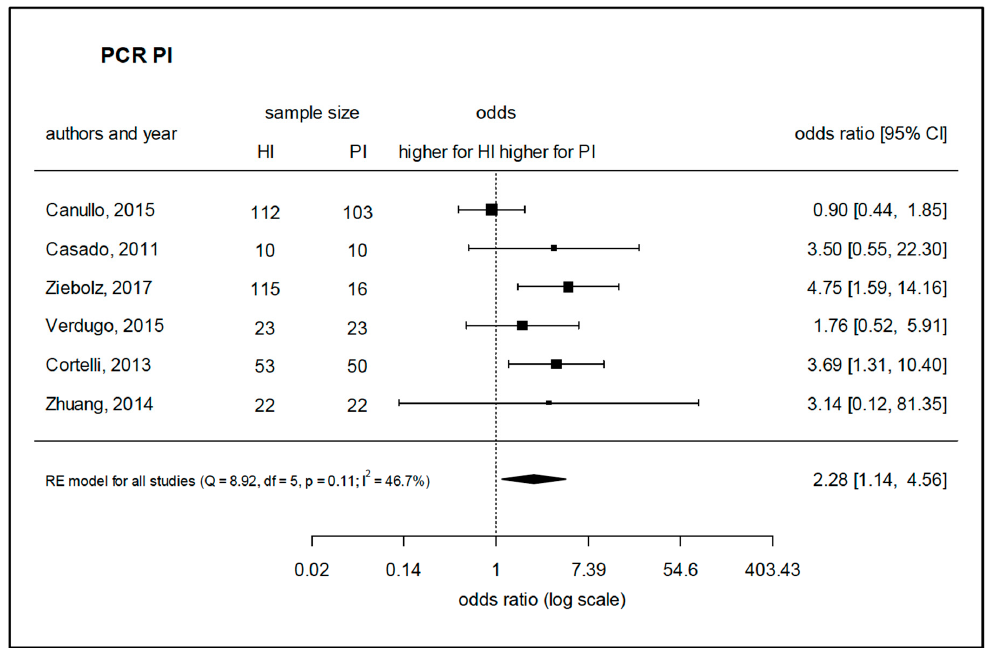
Figure 5. Meta-analysis for the presence of Porphyromonas gingivalis in either healthy sites or peri-implantitis sites (studies performing PCR-based analysis). HI—healthy implants, PI—implants with peri-implantitis, Q—Cochrane’s Q, df—degrees of freedom, p —level of significance, I 2 —proportion of observed variance (heterogeneity).